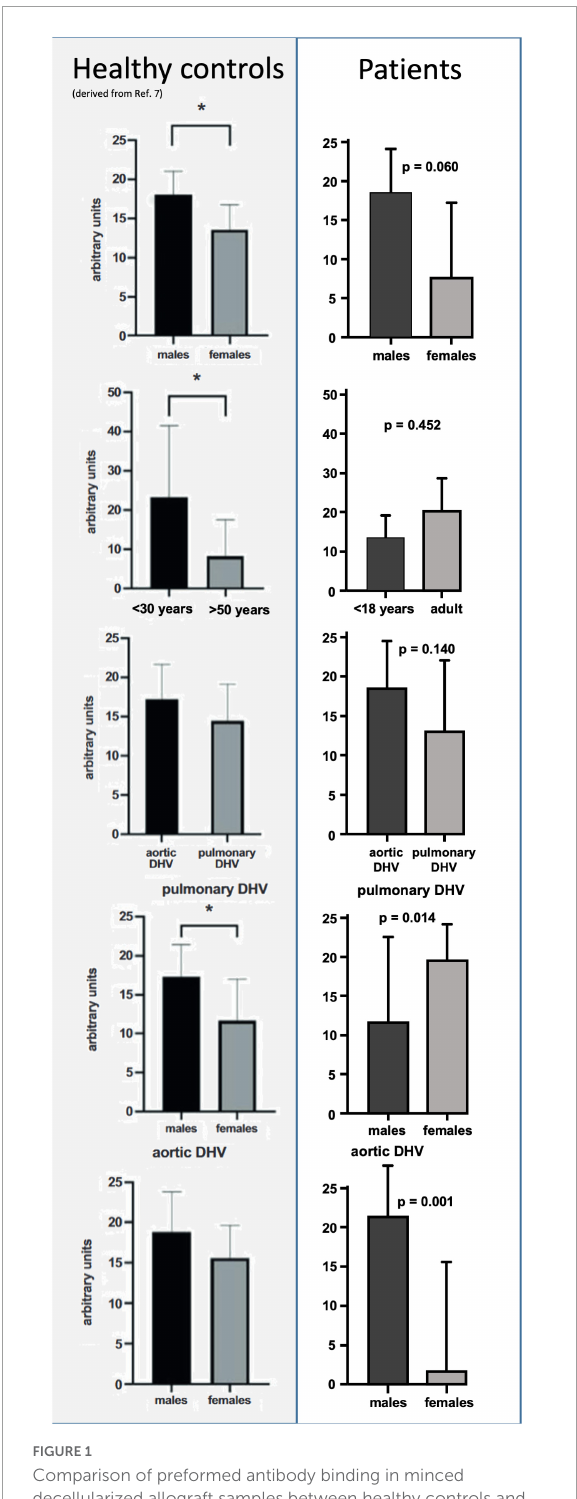
FIGURE1 Comparison of preformed antibody binding in minced decellularized allograft samples between healthy controls and patients who had received decellularized allografts according to sex, age, and valve position. Data from healthy controls were taken from our previous publication (7). Please note the different age categories in healthy controls, which were all over 18 years of age. Asterisks indicate statistical